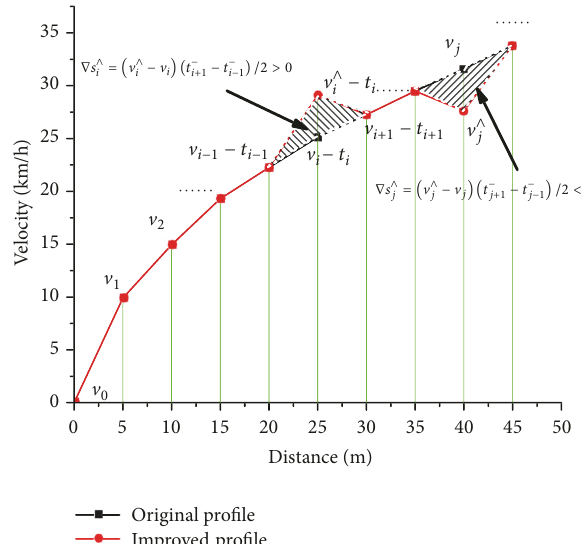
Figure 12: Explanation of changes of velocity and